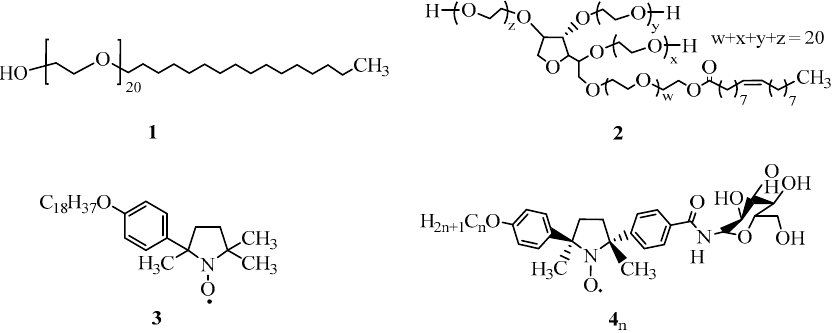
Figure 1. Molecular structures of non-ionic surfactants Brij 58 ( 1 ) and Tween 80 ( 2 ), and nitroxide radicals 3 and 4 n ( n = 14, 16, and 18). Compounds 4 n are a ca. 1:1 mixture of D –( R , R ) and D –( S , S ) diastereomers, see the Supporting Information for the synthesis and characterization.